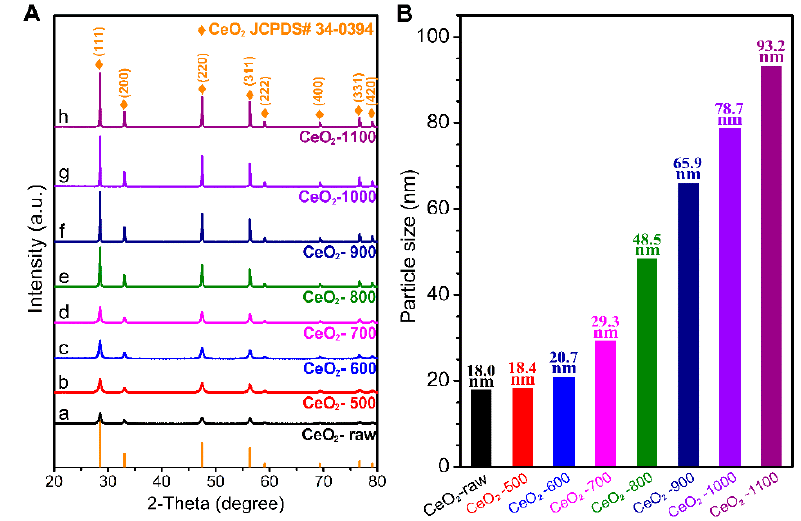
Figure 2. ( A ) X-ray diffraction (XRD) patterns of CeO 2 -raw and CeO 2 -x; ( B ) comparison of particle size based on the calculation using the Scherrer equation on the basis of the (111) peak.